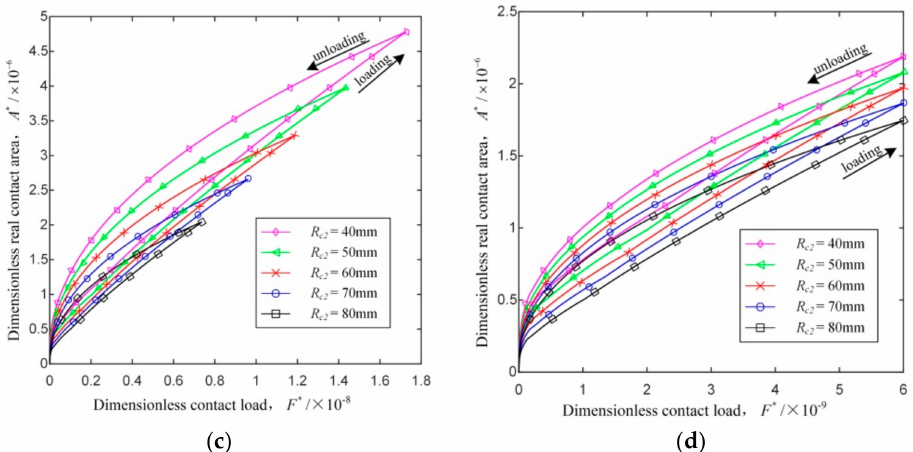
Figure 5. The relation between real contact area and contact load of two cylindrical surfaces in the second elastoplastic stage with di ff erent curvature radii with D = 1.5, G = 10 − 10 mm and R c1 = 100 mm. ( a ) Unloading at the dimensional critical contact load; ( b ) unloading at a given dimensional contact load; ( c ) unloading at the dimensionless critical contact load; ( d ) unloading at a given dimensionless contact load.